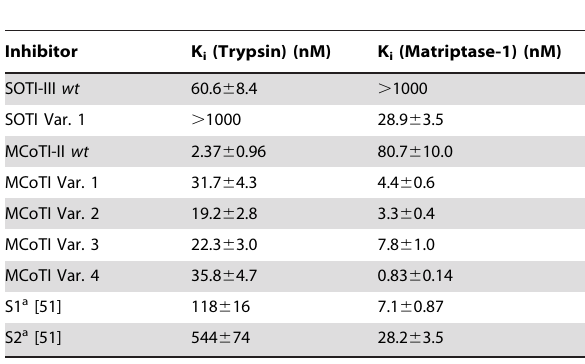
Table 1. Inhibition constants of inhibitors studied in this